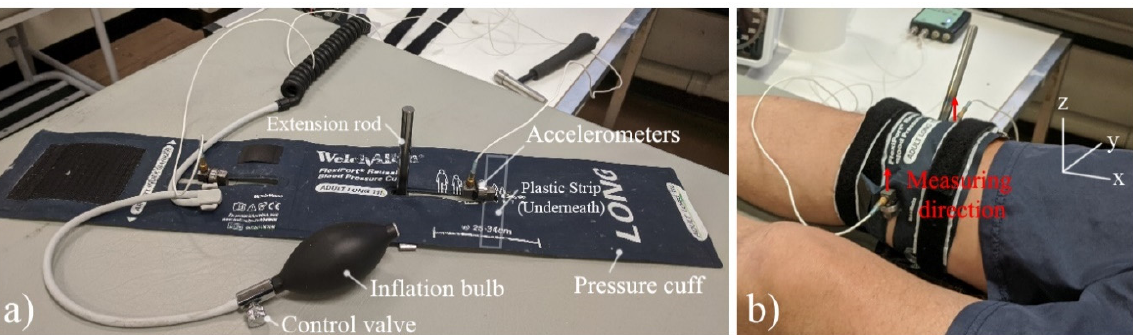
Figure 1. ( a ) Labelled prototype device and ( b ) installed prototype device on participant’s knee.